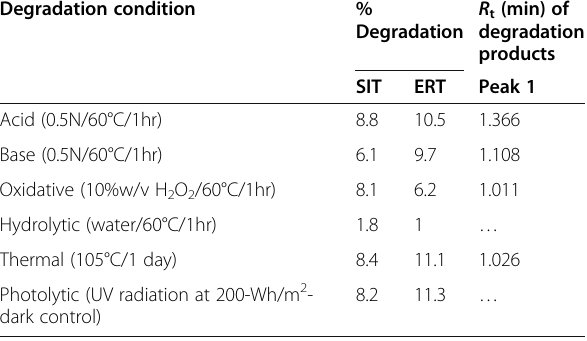
Table 9 Summary of degradation data of SIT and ERT Degradation condition